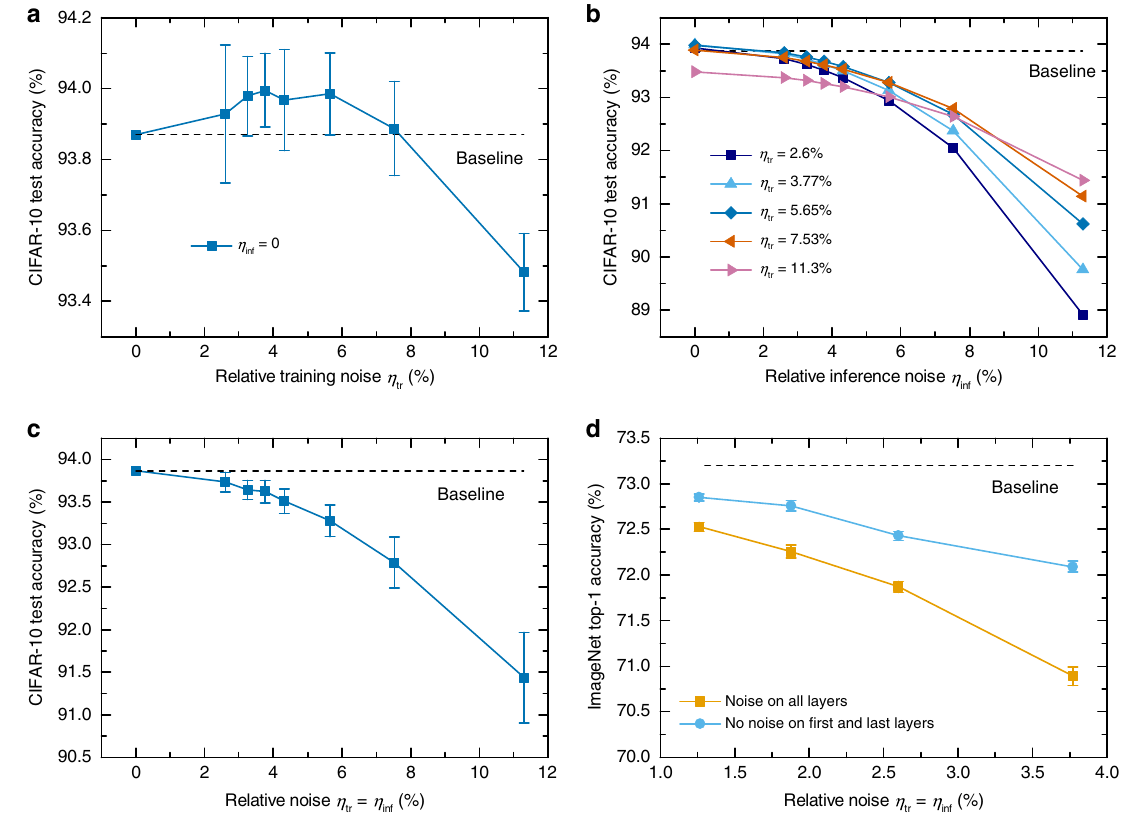
Fig. 2 Impact of injecting weight noise during training and inference on network accuracy. a Test accuracy on CIFAR-10 obtained for different amounts ¼ 0). When η of relative injected weight noise during training η without inducing any perturbation during inference ( η > 8 % , the training convergence tr inf tr starts to become affected by the high noise and it is not possible anymore to reach the software baseline within the same number of epochs. The error bars represent the standard deviation over 10 training runs. b Test accuracy on CIFAR-10 obtained for the networks trained with different amounts of relative weight noise η as a function of the weight noise injected during inference η . In most cases, η can be increased above η up to a certain point and still tr inf tr inf ¼ η lead to comparable or slightly higher (within ≈ 0.1%) test accuracy than for η . However, when η becomes much higher than η , the test accuracy tr inf tr inf decreases due to the inability of the network to achieve baseline accuracy when η 8 % . Each data point represents the average over 10 training runs and tr > ¼ η 100 inference runs. c Test accuracy on CIFAR-10 as a function of η . The error bars represent the standard deviation over 100 inference runs tr inf ¼ η averaged over 10 training runs. d Top-1 accuracy on ImageNet as a function of η . The error bars represent the standard deviation over 10 inference tr inf runs on a single training layer and the last dense layer, and performed inference with the fi rst and last layer without noise. The obtained accuracy after training, by injecting the same training and inference noise as previously, can be increased by more than 1% with this technique (see Fig. 2d).